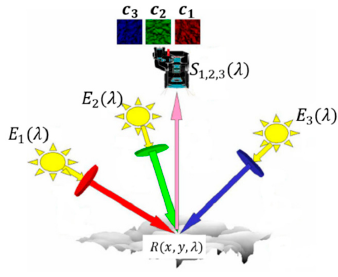
Figure 1. The illustration of multi-spectral photometric stereo.